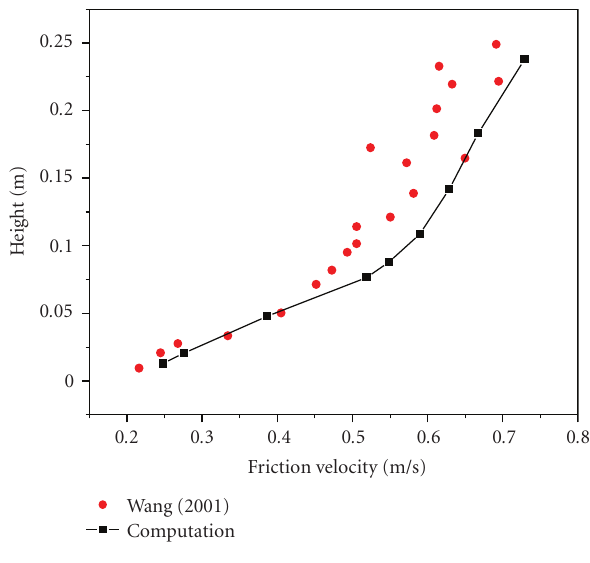
Figure 6: Trajectory height versus friction velocity.